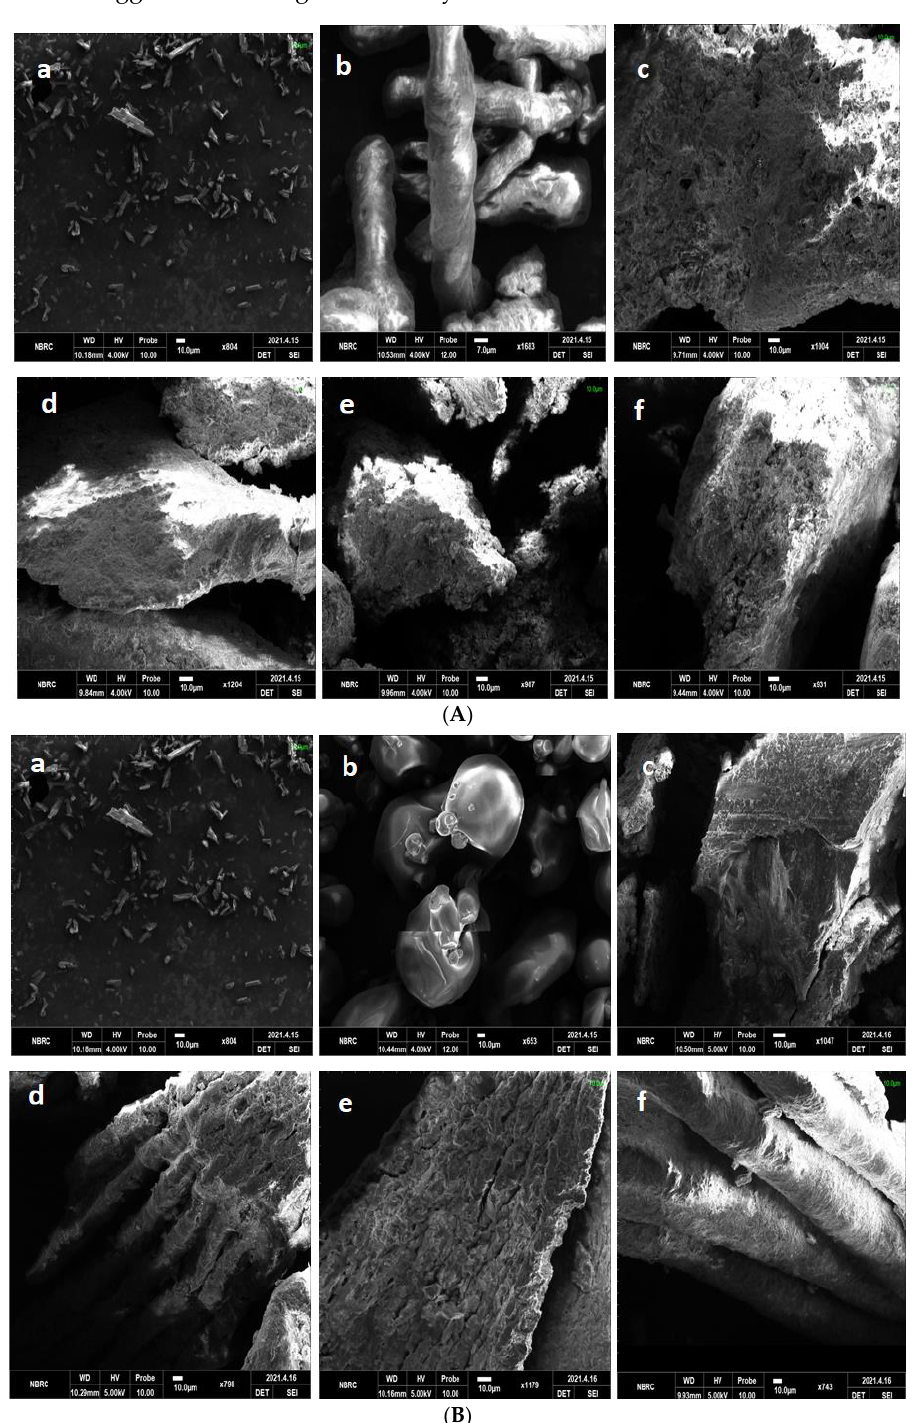
Figure 3. ( A ). SEM images of pure curcumin ( a ), HPMC E5 ( b ), CUR:HPMC E5 1:2 KN ( c ), CUR: HPMC E5 1:4 KN ( d ), CUR:HPMC E5 1:2 SE ( e ), and CUR: HPMC E5 1:4 SE ( f ). ( B ). SEM images of pure curcumin ( a ), PVP K30 ( b ), CUR:PVP K30 1:2 KN ( c ), CUR:PVP K30 1:4 KN ( d ), CUR:PVP K30 1:2 SE ( e ), and CUR:PVP K30 1:4 SE ( f